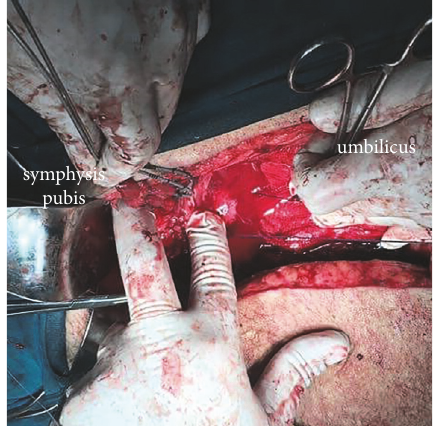
Figure 6: Closure of the bladder using the viable tissue from the posterior wall and